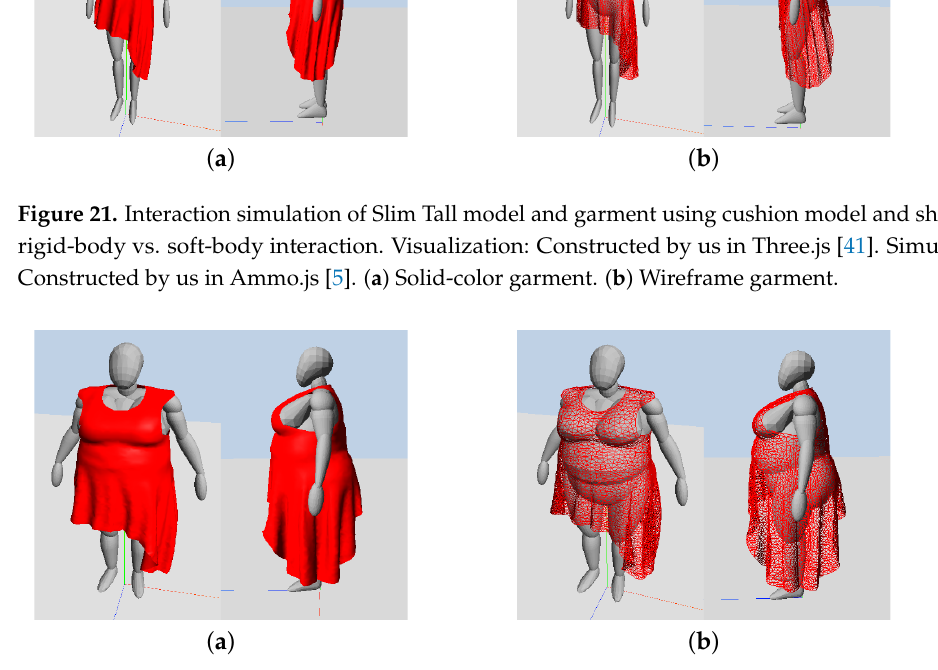
Figure 22. Interaction simulation of Chubby Small model and scaled garment using cushion model and showing rigid-body vs. soft-body interaction. Visualization: Constructed by us in Three.js [41]. Simulation: Constructed by us in Ammo.js [5]. ( a ) Scaled garment. ( b ) Wireframe scaled